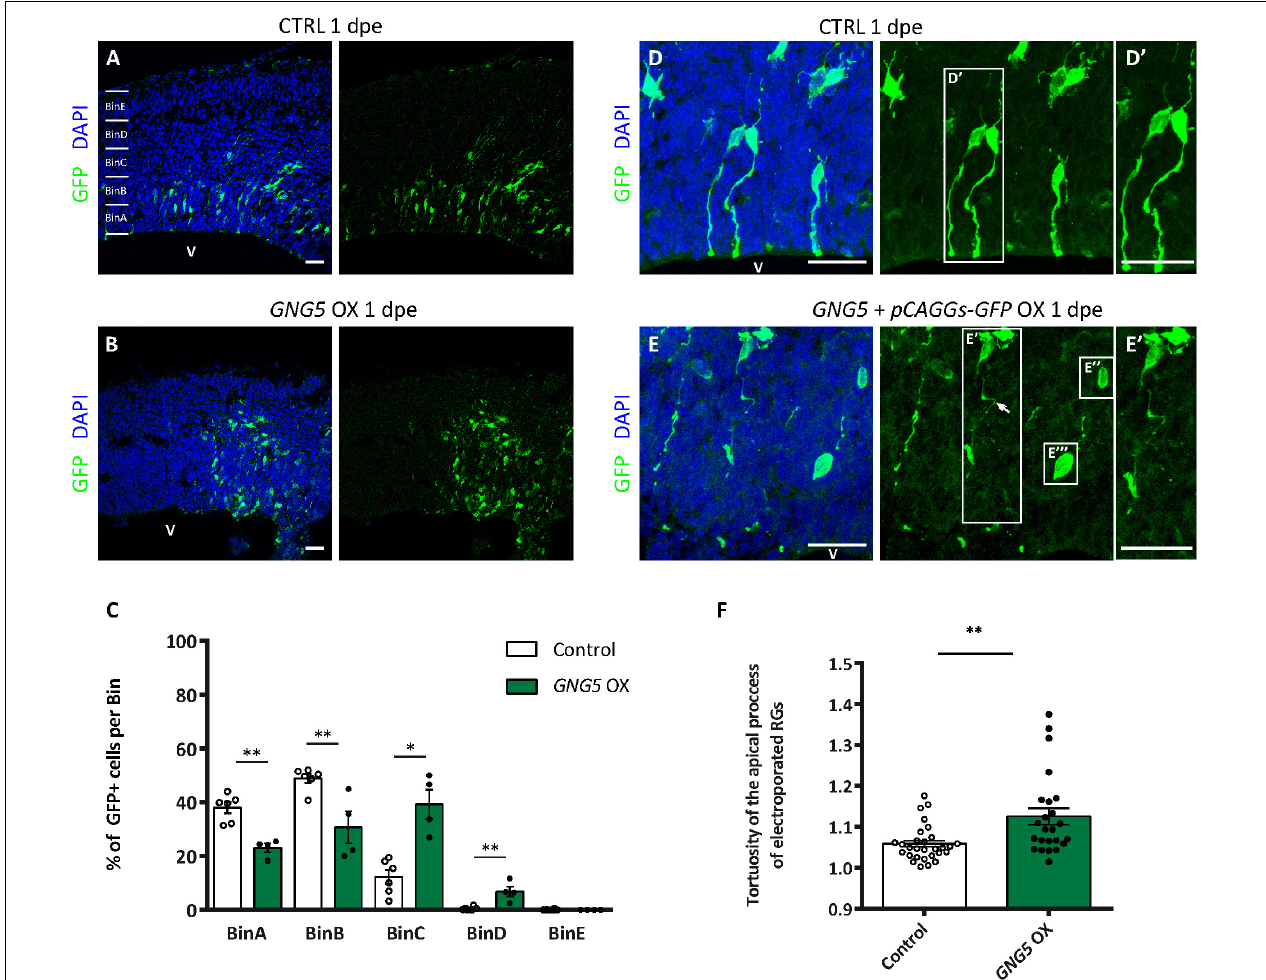
FIGURE 3 | Acute overexpression of GNG5 in mouse embryos at E13 alters transfected cell morphology and induces changes in the distribution of cells one day after electroporation. (A,B) Representative pictures of electroporated mouse brain sections stained for GFP. Sections were divided into five equal bins. (A) In embryos electroporated with the control plasmid, GFP+ cells stay in the first 2 bins while in (B) GNG5 OX mice, GFP+ cells can be found in superficial bins. (C) Distribution of GFP+ cells per bin in control and GNG5 OX mice at E13-E14. (D–E (cid:48)(cid:48)(cid:48) ) Representative pictures of the morphology of transfected cells with control or GNG5 plasmids co-electroporated with the control plasmid. ( E (cid:48) ) Arrows indicate the cells with a non-straight morphology and ( E (cid:48)(cid:48) ,E (cid:48)(cid:48)(cid:48) ) cells that delaminate or do not have processes mainly present in GNG5 OX embryos. ( F ) Tortuosity of the electroporated aRGs in control and GNG5 OX mice. Statistical significance was based on Mann-Whitney test ∗ p < 0.05 and ∗∗ p < 0.01. (A–C) Control n = 6 and GNG5 OX n = 4. ( D–F ) Control n (cells) = 29 and GNG5 OX n (cells) = 24. Data are represented as mean ± SEM. Scale bar: 30 µ m. Abbreviations: CTRL, control; OX, overexpression; V,